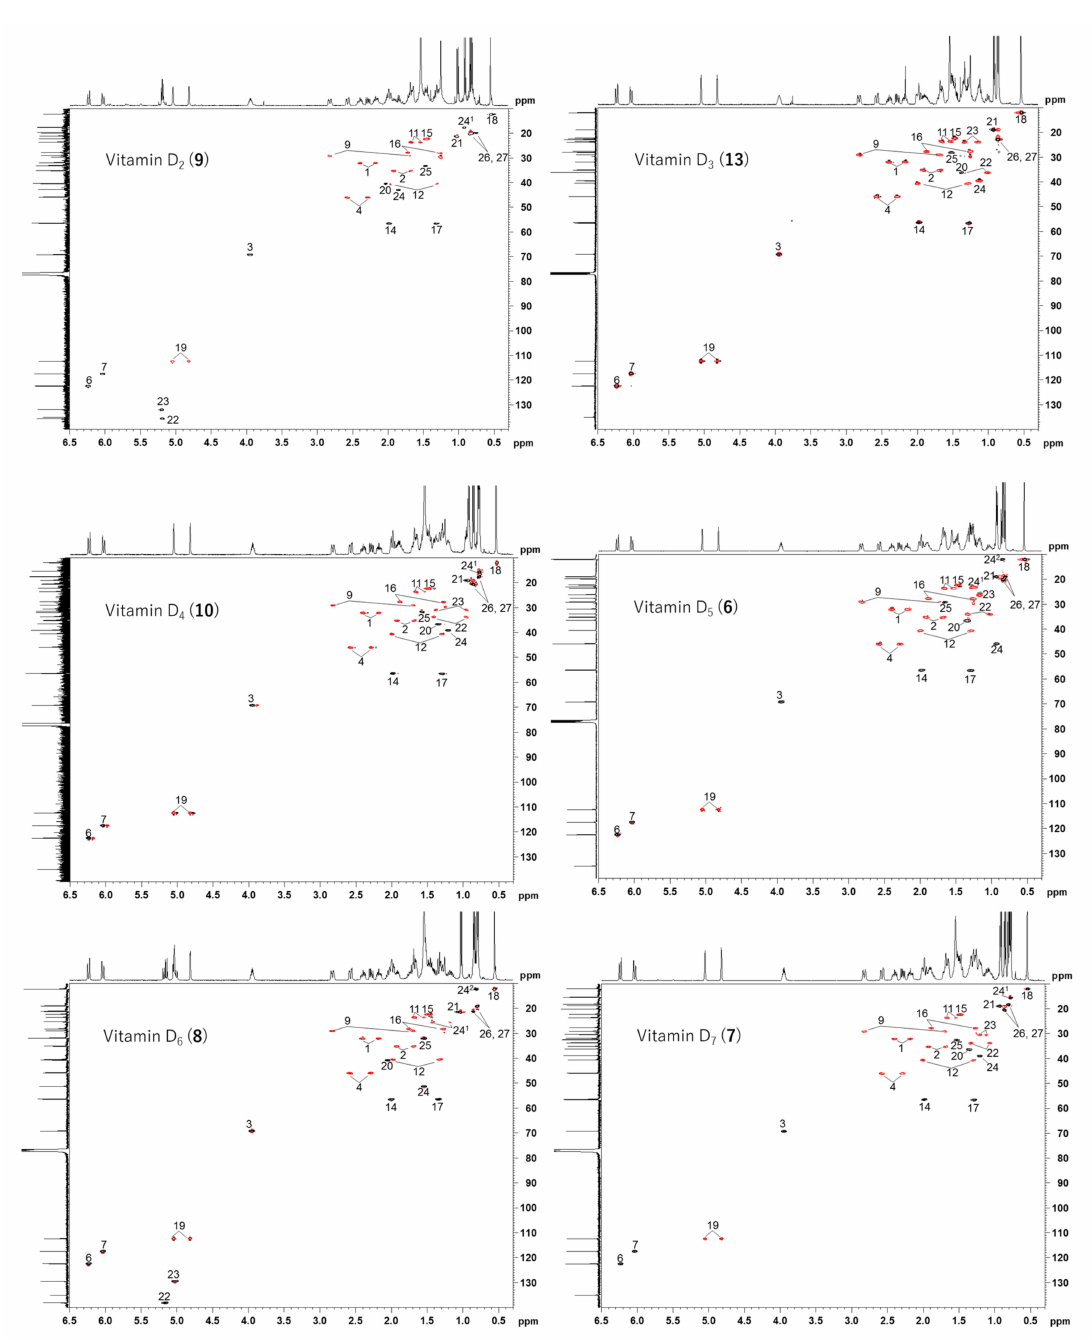
Figure 6. HSQC NMR spectra of vitamins D 2 ( 9 ), D 3 ( 13 ), D 4 ( 10 ), D 5 ( 6 ), D 6 ( 8 ), and D 7 ( 7 ). Methine (CH) / methyl (CH 3 ) resonances have a positive intensity and are plotted in black; methylene (CH 2 ) resonances have a negative intensity and are plotted in